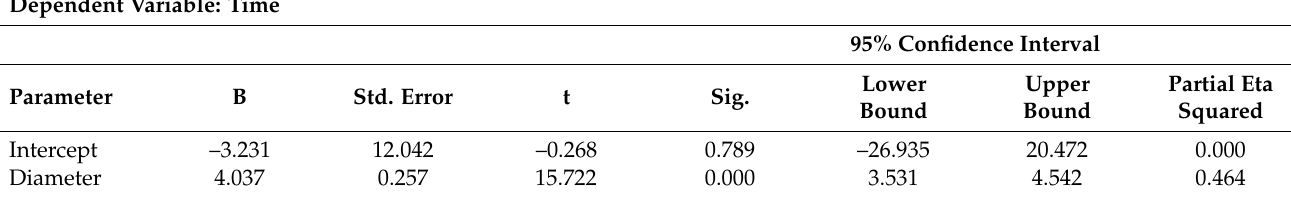
Table 13. Parameter